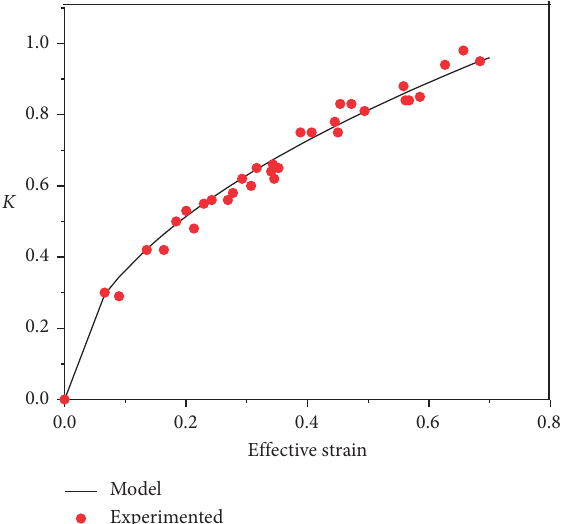
Figure 6: Relationship between actual void closure ratio and ef- fective strain.